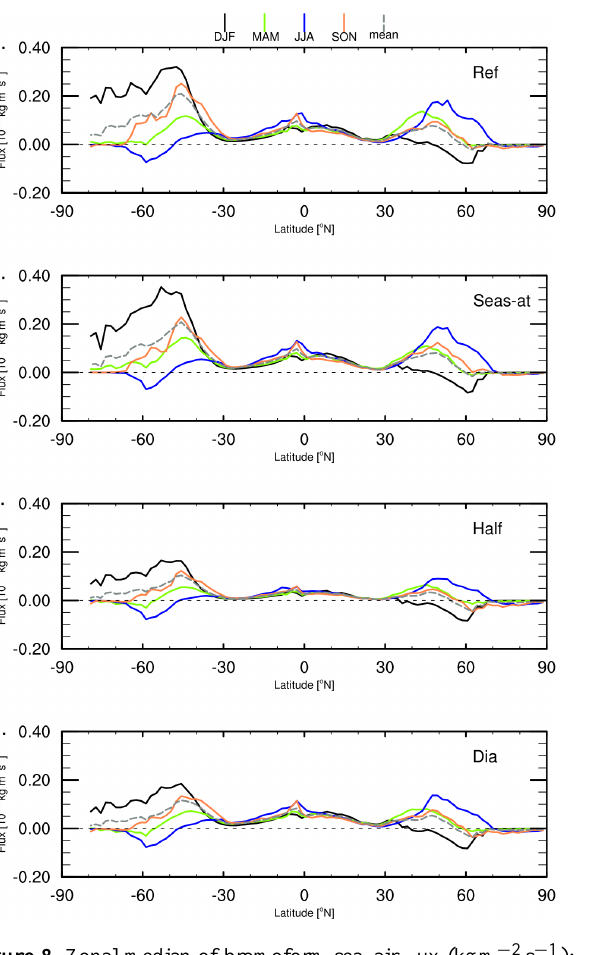
Figure 8. Zonal median of bromoform sea–air flux (kgm − 2 s − 1 ); mean of JJA (blue), DJF (black), MAM (green), and SON (orange); and annual mean (dashed grey). Results are from Ref (a) , Seas-at (b) , and Half (c) , and Dia (d) .